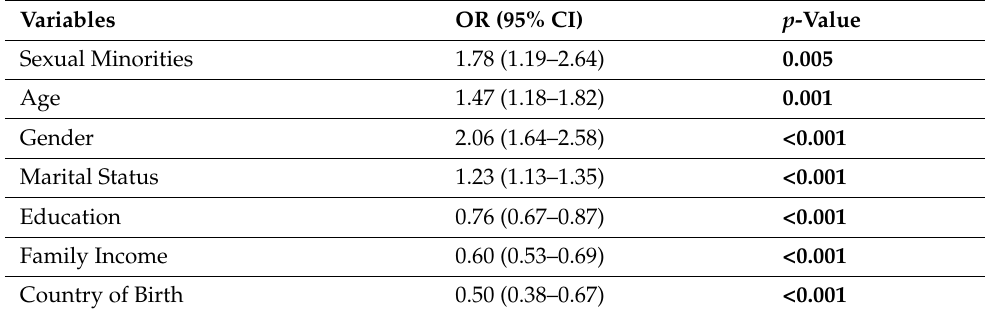
Table 4. Regression analysis on the association of demographic characteristics with severity of depression (adjusted